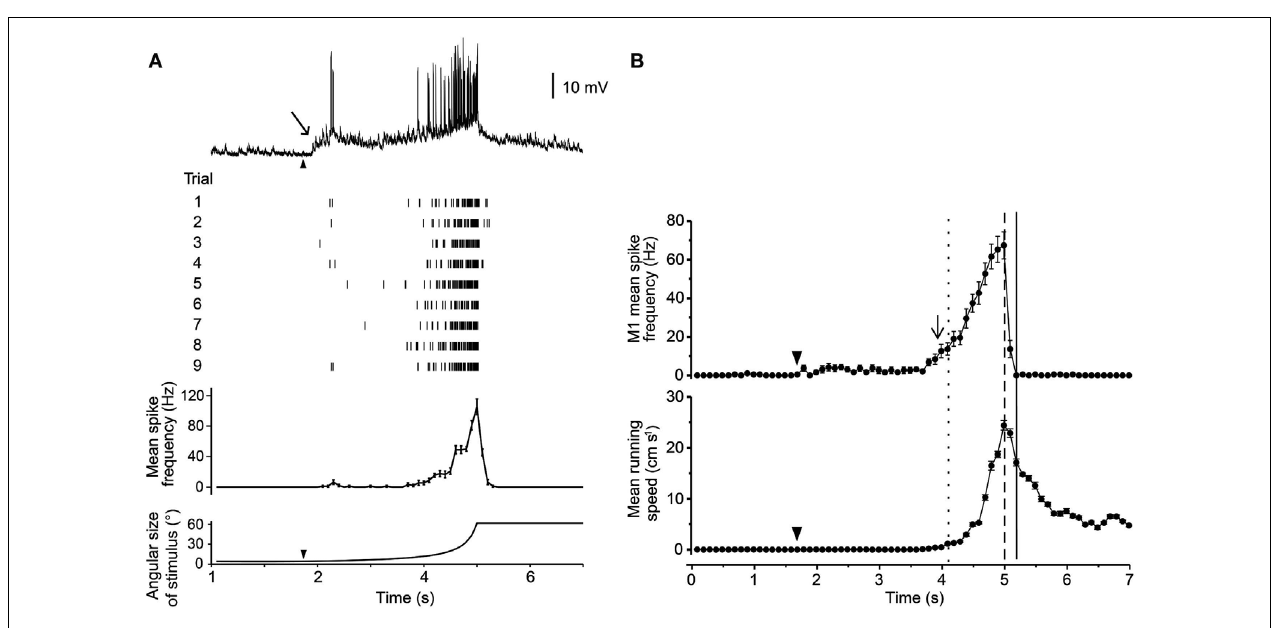
size of the looming object is shown in bottom trace. (B) Mean spike rate from a single LG neuron (top) and mean escape running speed (bottom). Arrowheads mark the start of stimulus expansion and long arrows mark increase in spike rate above resting level. Adapted with permission from Oliva et al.